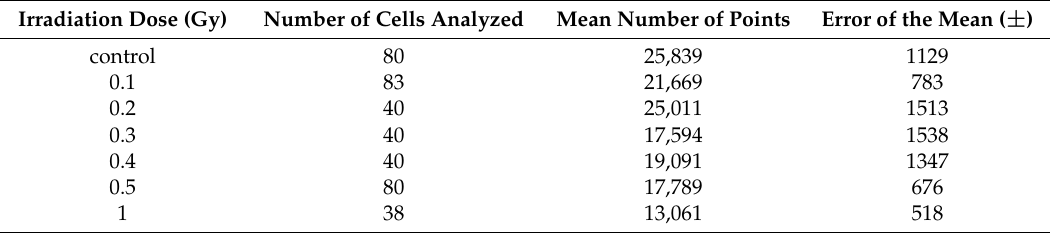
Table 1. Results of independent low dose radiation experiments using specific COMBinatorial oligo-nucleotide fluorescence in situ hybridization (COMBO FISH) labeling with a unique oligonucleotide-probe for the ALU consensus